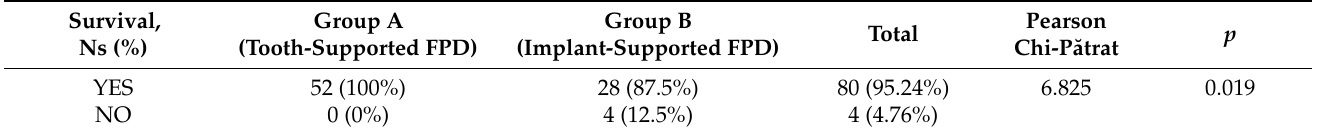
Table 4. Rate of survival (tooth-supported FPDs vs. implant-supported FPDs).